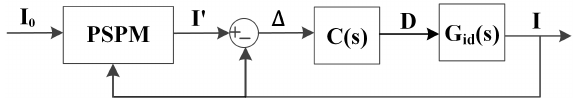
Figure 2. The closed-loop model of the multicharger